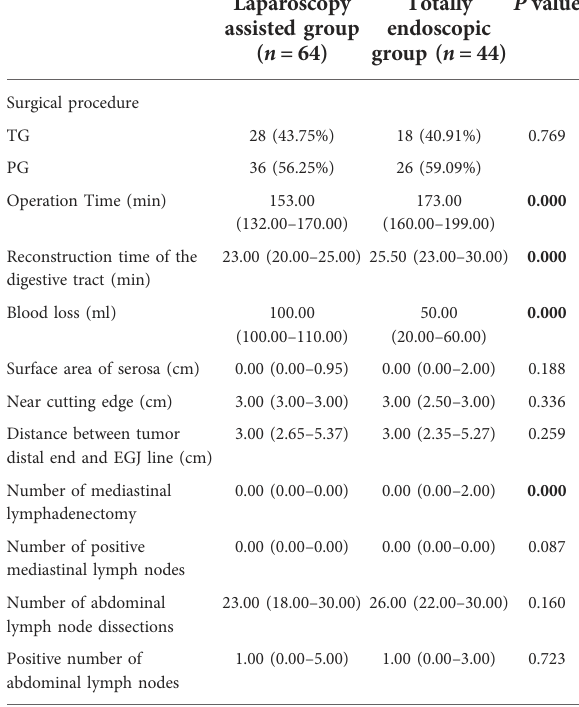
TABLE 2 intraoperative correlation index.